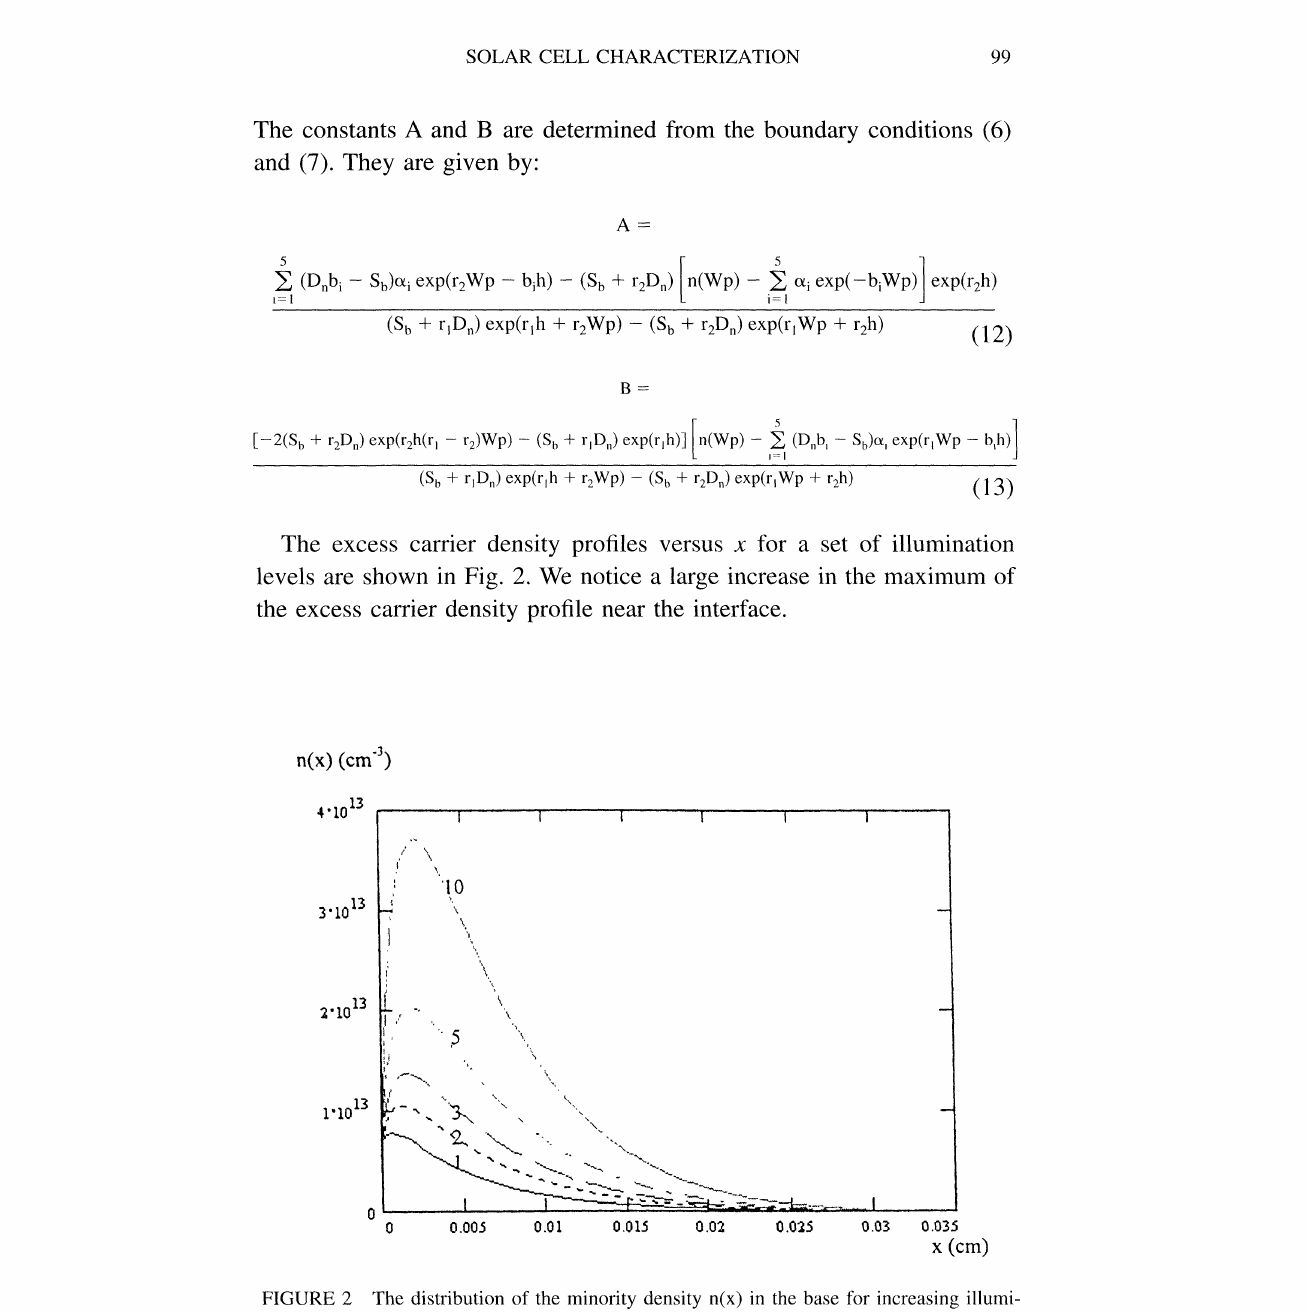
FIGURE 2 The distribution of the minority density n(x) in the base for increasing illumi- nation levels and for the operating potential Vj 0.5 Volt. The parameters of the solar cell are: N A 10 6 cm-3; S 105 cm.s-| and h 0.03 cm. The light concentration factor is indicated on the graph (rising from sun to 10